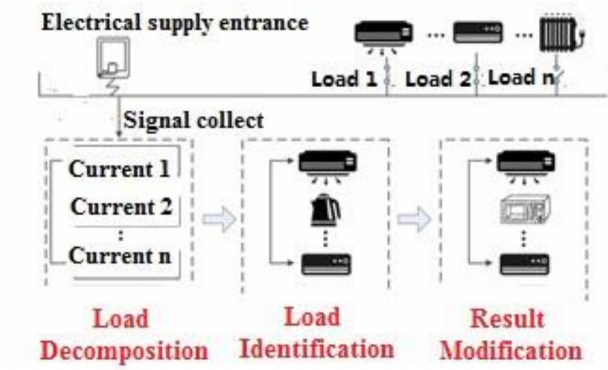
Figure 2. Overall structure of non-intrusive load monitoring (NILM).